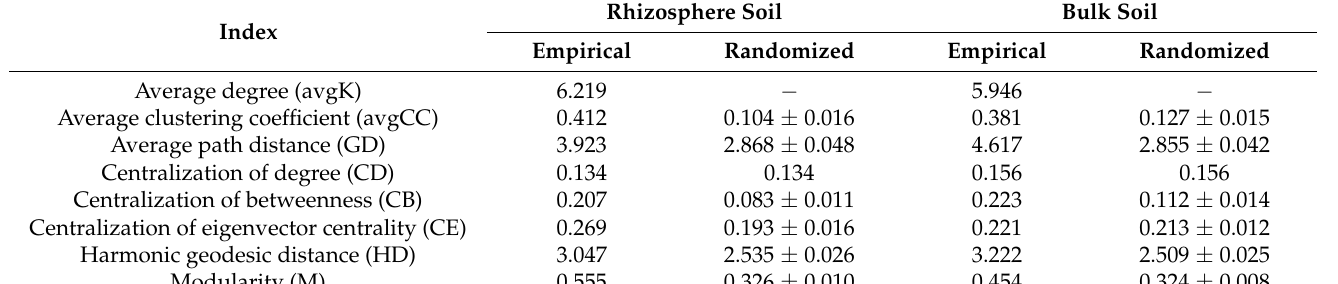
Table 2. Statistics of the topological parameters of empirical and randomised networks in the rhizosphere and bulk soils.